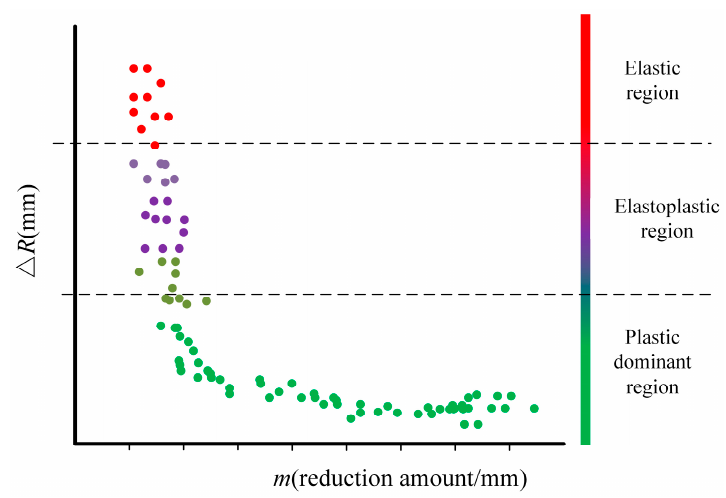
Figure 1. Schematic diagram of data distribution after clustering.